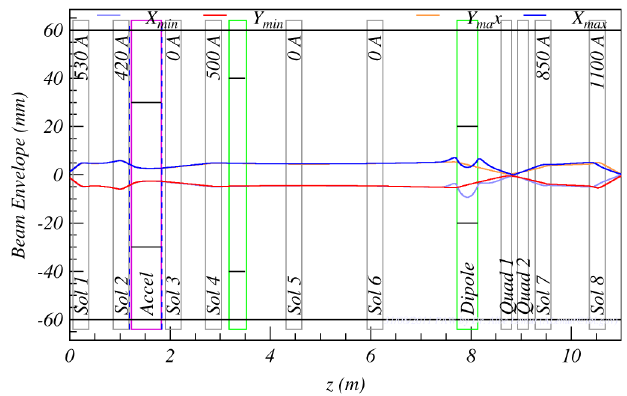
FIG. 16. 4 He þ 400 keV 625 (cid:4) A (350 kV postacceleration, 250 W, neutralization 90%) beam envelopes through the solid- target station beam line. The two high-energy quadrupoles are shown but not used in the present calculation.